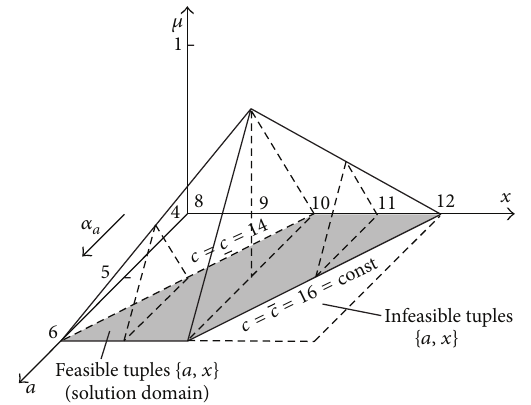
Figure 19: 3D projection of the full 4D solution of (64) from the space 𝐴 × 𝐶 × 𝑋 × 𝜇 onto the space 𝐴 × 𝑋 × 𝜇 .